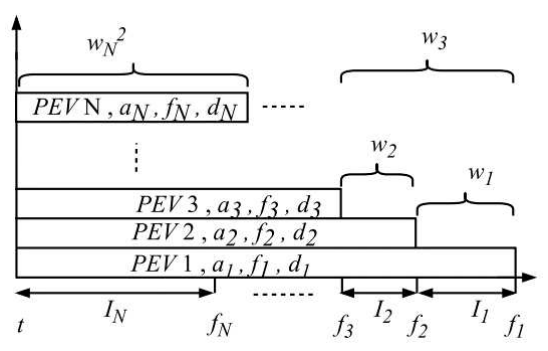
Figure 4. Online PEV charging